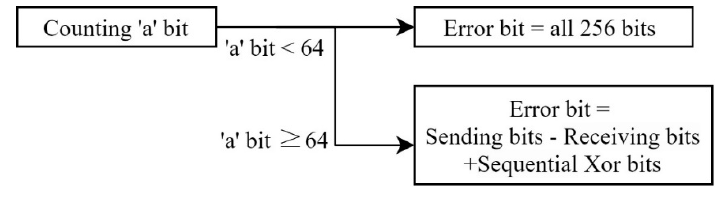
Figure 6. Synchronization with preamble bit.